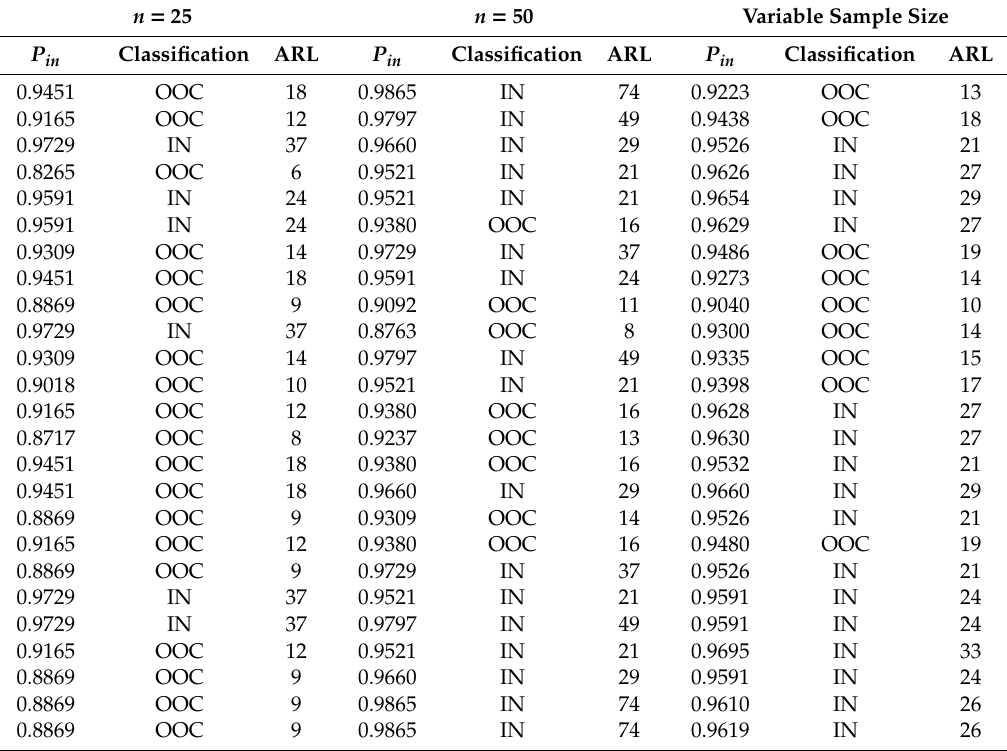
Table 4. Classification of the